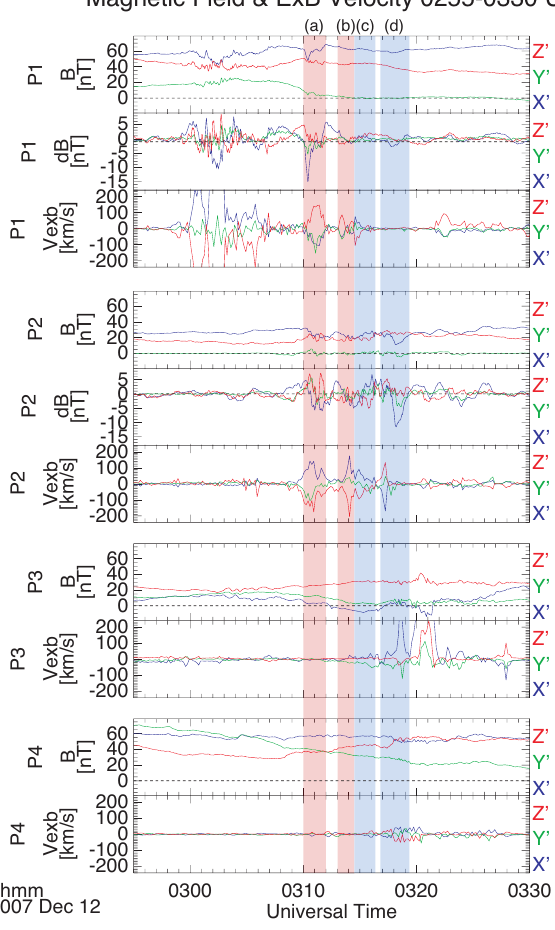
Fig. 3. The magnetic field and E × B velocity obtained in the new coordinate system (see Sect. 3.2). For P1 and P2, the deviations from the magnetic field smoothed with a 5-min average window are presented. Red and blue shadows indicate activations (a–d) during which more than one probe observed fast E × B